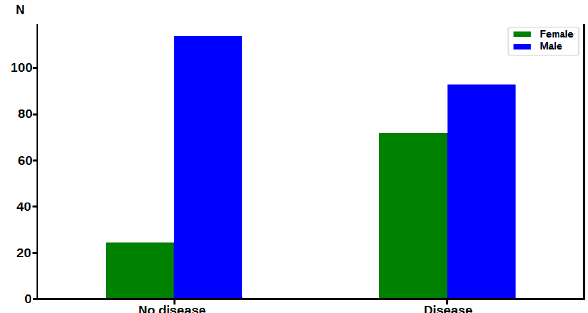
Figure 4. Sex and risk of MI.